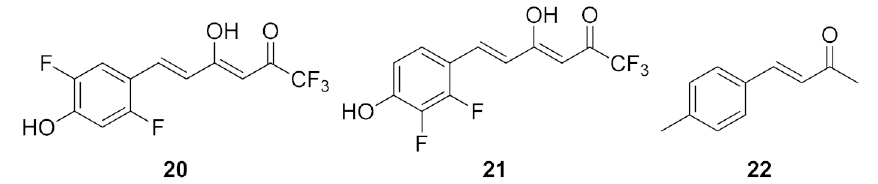
Figure 9. Structures of hemi-curcuminoids.